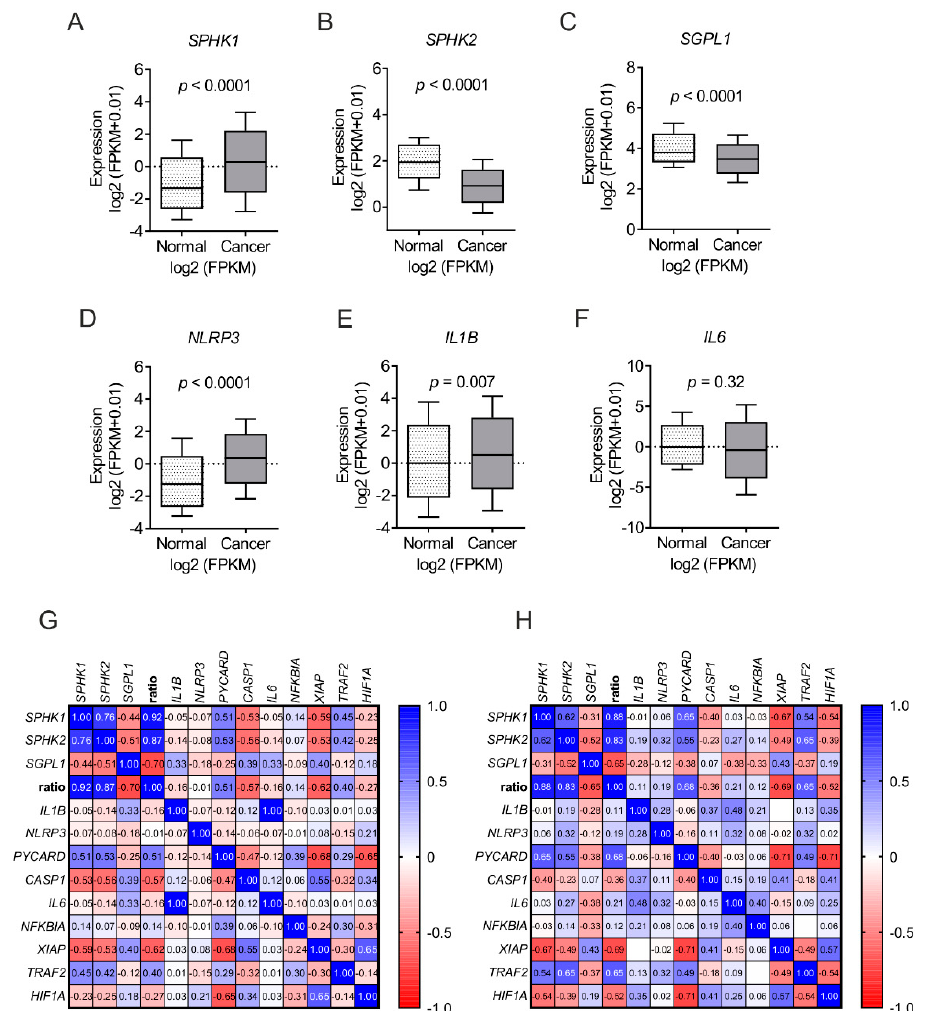
Figure 6. Clinical correlation between SPHKs and NLRP3. The expression of S1P metabolizing enzymes were correlated with that of NLRP3 inflammasome components in kidney renal cell carcinoma and psoriatic skin. Publicly available TCGA-KIRC datasets of cancer and normal adjacent tissue were analyzed for the expression of ( A ) SPHK1 , ( B ) SPHK2 , ( C ) SGPL1 , ( D ) NLRP3 , ( E ) IL1B and ( F ) IL6 from tumor (cancer; n = 535) and normal (normal; n = 72) samples. Results are presented as log 2 fragments per kilobase of transcript per million mapped reads (FPKM). Gene expression data in Gene Expression Omnibus (GEO) dataset GSE54456 comprising of ( G ) normal skin ( n = 82 and ( H ) psoriatic skin ( n = 92) were analyzed for NLRP3 inflammasome components ( IL1B, NLRP3, PYCARD and CASP1 ) and NF- κ B target genes ( IL6 , NFKBIA , XIAP , TRAF2 and HIF1A ) with an in silico generated S1P production ratio. Spearman r -values are indicated. P values were calculated using two-tailed Student’s t